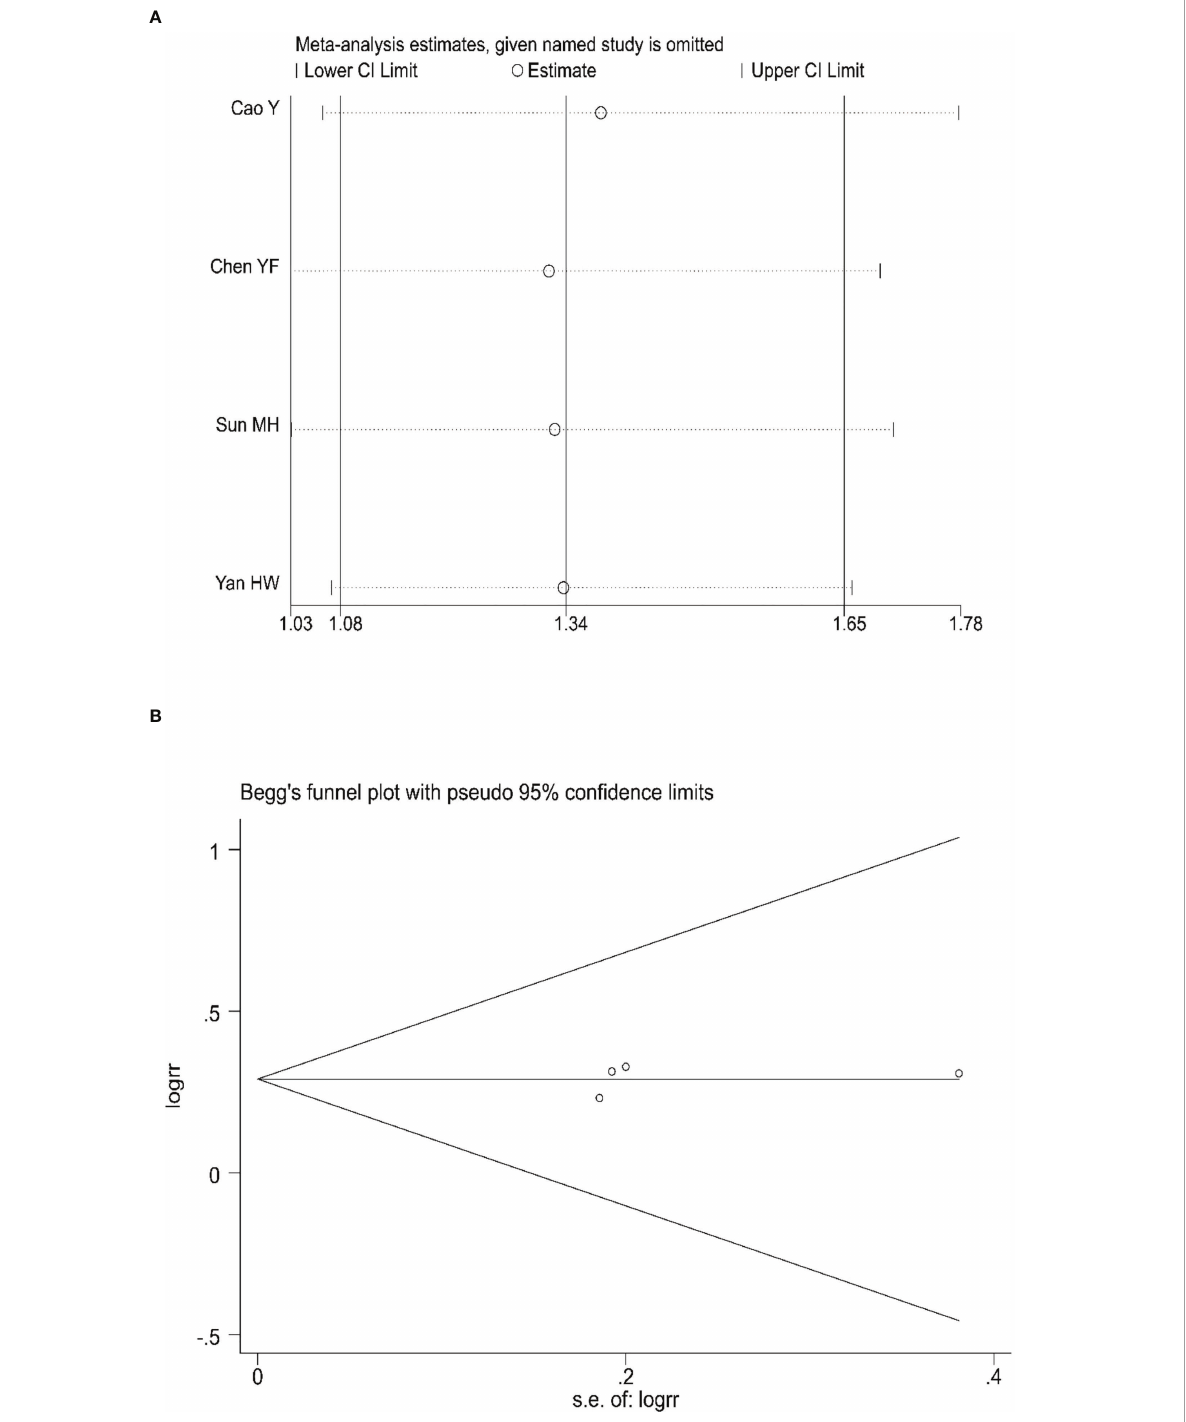
FIGURE 7 Sensitivity analysis (A) and Begg ’ s funnel plot (B) for the analysis of CRR. (Begg ’ s test: p = 0.734). CRR, complete remission